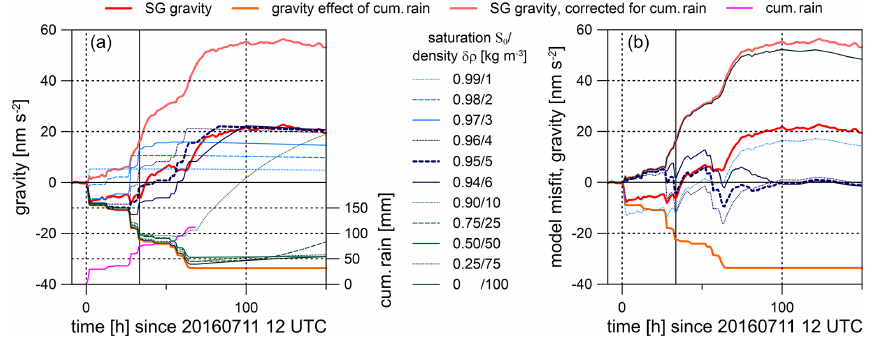
Figure 13. Modelled gravity response for a real cumulative rain function (monitored between 11 and 14 July 2016) for different degrees of initial saturation S 0 . Model response (a) and model mismatch (b) . Observed gravity (red), cumulative rain (magenta) and gravity effect of cumulative rain (orange) are shown for comparison. Black vertical lines indicate the onset of the long-term anomaly. The right panel displays results only for the best-fitting models (0 . 94 ≤ S 0 ≤ 0 . 96) and for S 0 = 0 and S 0 = 0 .